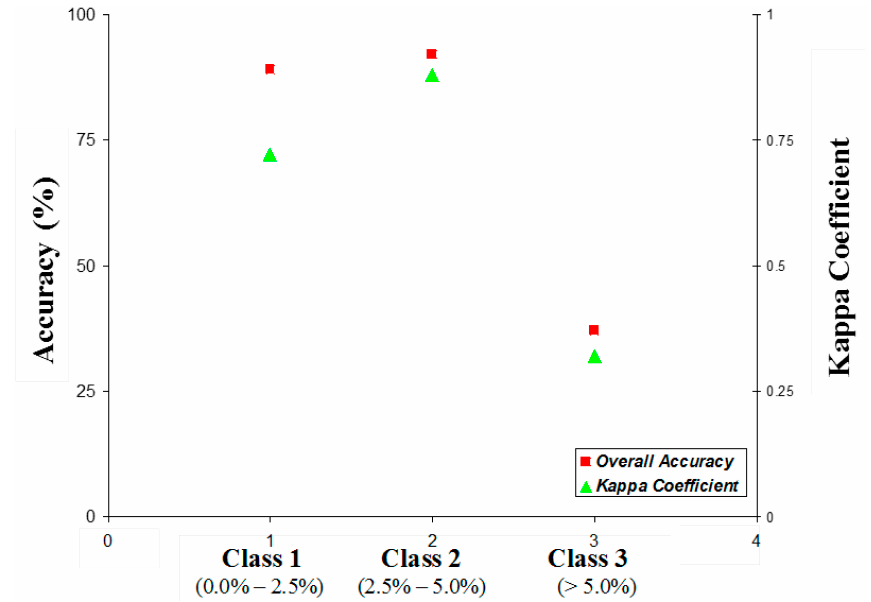
Figure 13. Kappa statistics for 2 August 2006 data set.